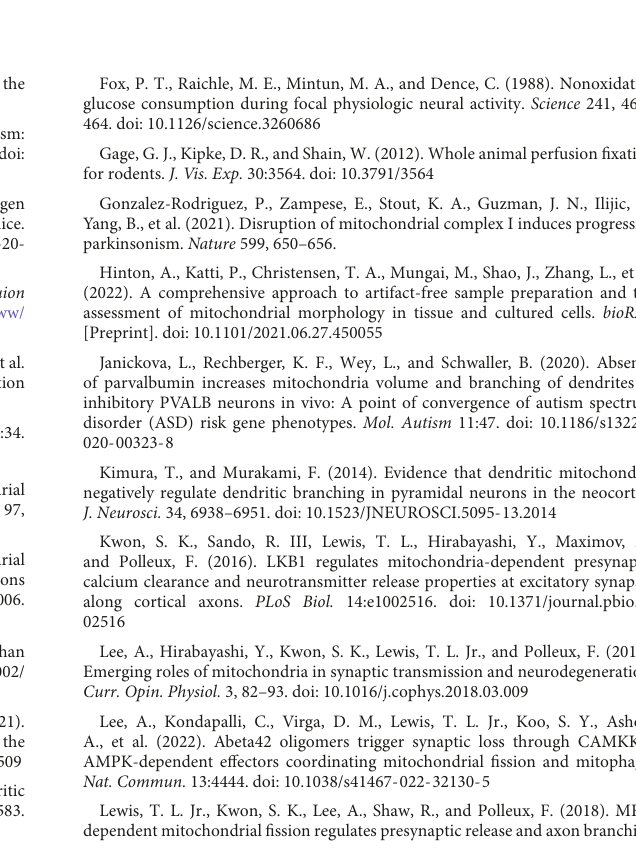
accumulation was confirmed with p- α -synuclein staining. Both in control and α -synuclein treated samples, 2% PFA/0.075%